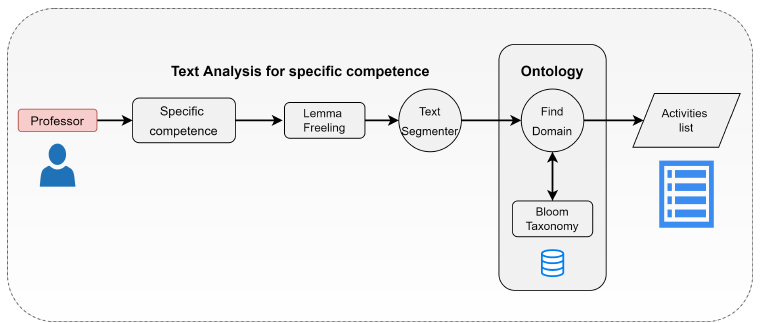
Figure 6. Segmentation process